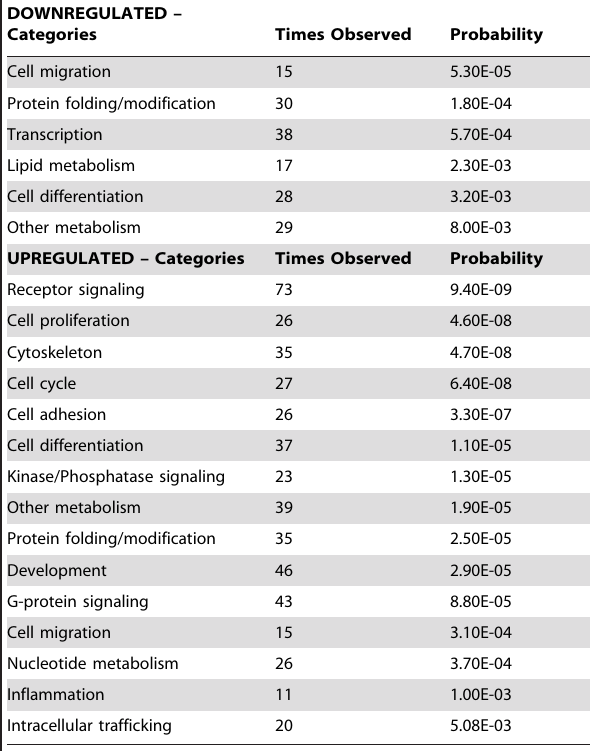
Table 1. Gene Ontology (GO) frequency distribution for downregulated and upregulated